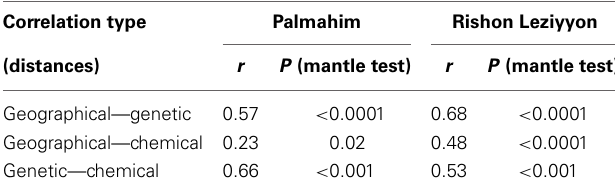
Table 3 | Correlation between geographical (between-nest distances), genetic (microsatellite variation) and chemical (cuticular hydrocarbon composition) distances of workers of Cataglyphis